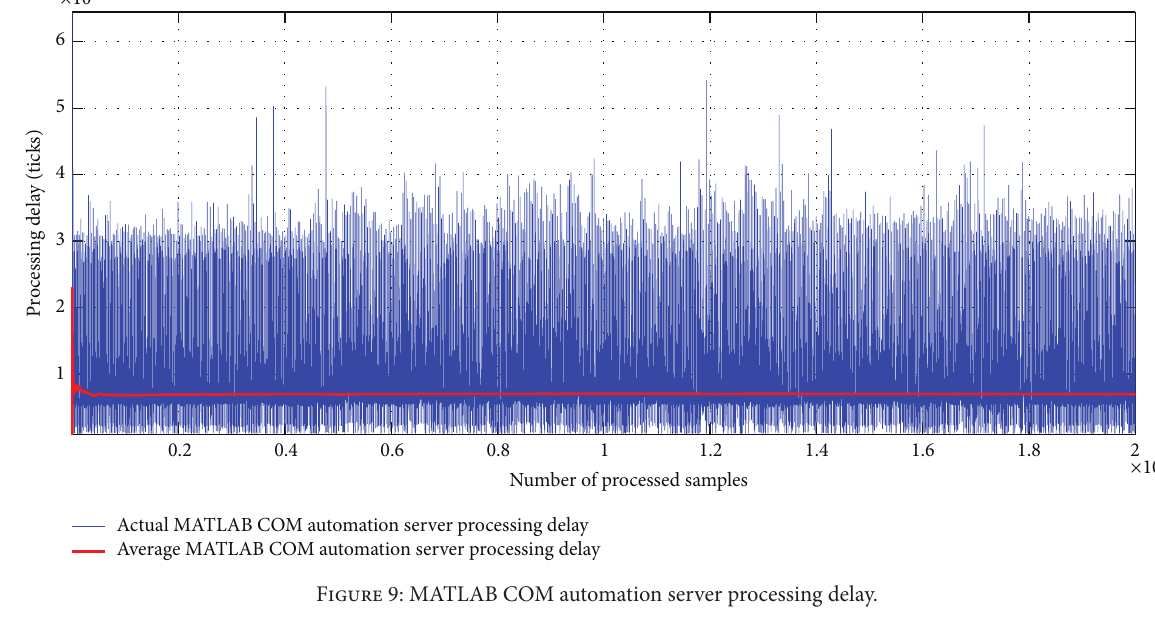
Figure 9: MATLAB COM automation server processing delay.